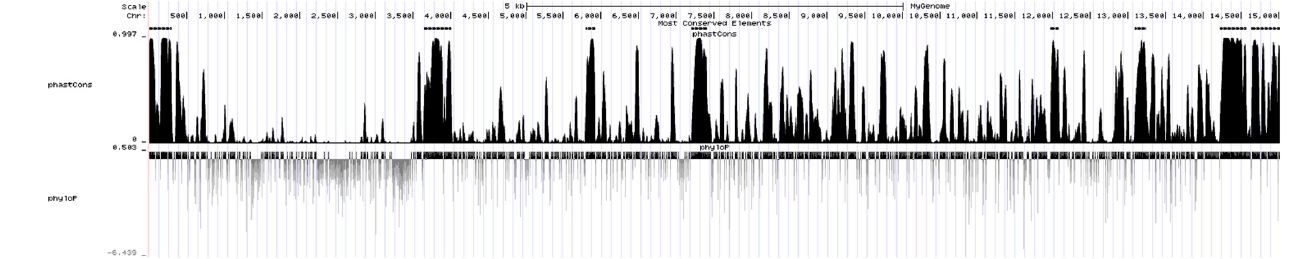
Figure 6. Conserved segments in the genome of CHsx1401 strain predicted by